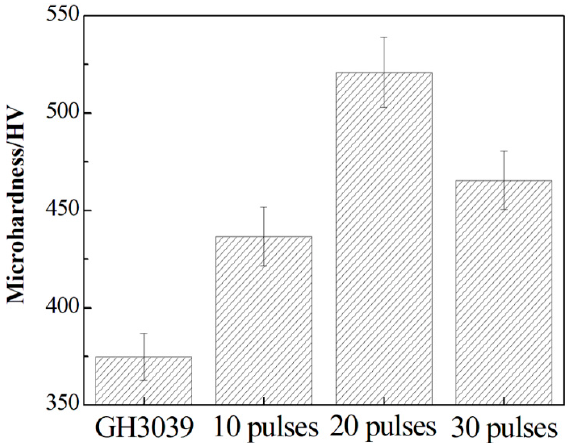
Figure 9. The hardness values for the Ni-Nb layer with the different number of pulses. Figure 10 gives the polarization curves of the Ni-Nb coating before and after HCPEB irradiation and the corresponding corrosion current ((i corr ) and corrosion potential (E corr ) were calculated and tabulated in Table 1. From Figure 10, it can be observed that the po- larization curve is divided into four parts: active region, passive transition zone, passive stabilization zone and active passive zone [31]. At the early stage, there were the crystal defects seen in the many HCPEB treated metals [20,25] with energy concentration inside microstructure at the topmost layer, which was easy to be corroded preferentially, form- ing the active region. Then hydrolysis of corrosion products promoted the formation of dense passivation film, resulting in a stable passivation area. The E corr and the I corr of the initial samples were − 0.990 V and 28.90 μ A·cm − 2 , respectively, as shown in Table 1. After HCPEB irradiation, the E corr and I corr of specimens were changed apparently. The Ecorr of 10- and 20-pulsed samples was increased to − 0.904 V and − 0.799 V and I corr decreased to 10.2 μ A/cm 2 and 6.98 μ A/cm 2 , respectively. As increasing the pulses number up to 30, the I corr increased to 7.83 μ A/cm 2 and the E corr decreased to − 0.887 V. Therefore, a drastic en- hancement of corrosion resistance was obtained for the Ni-Nb layer with 20 pulses com- pared to that of other samples. Table 1. Icorr and Ecorr of the Ni-Nb coating before and after HCPEB irradiation. Samples E corr (V) I corr ( μ A·cm − 2 ) GH3039